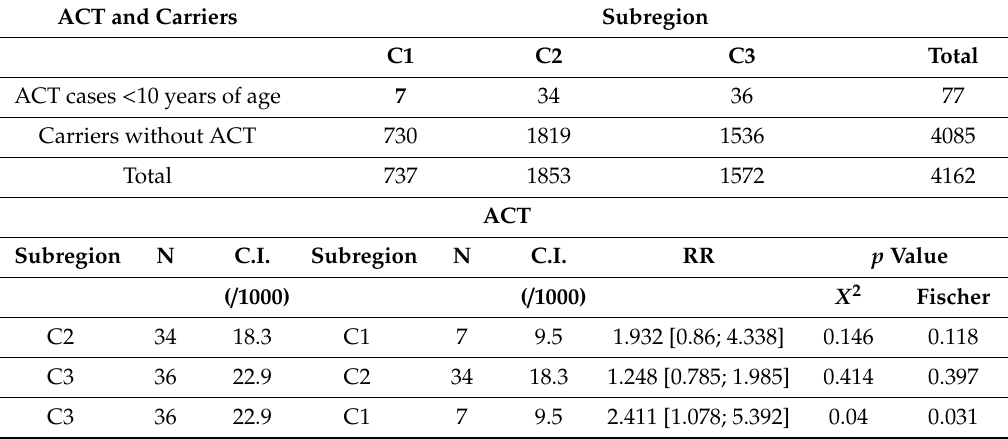
Table 1. Cumulative adrenocortical tumor (ACT) incidence among TP53 R337H carriers, ACT cases, and relative risk (RR) per subregion based on the 2006-C